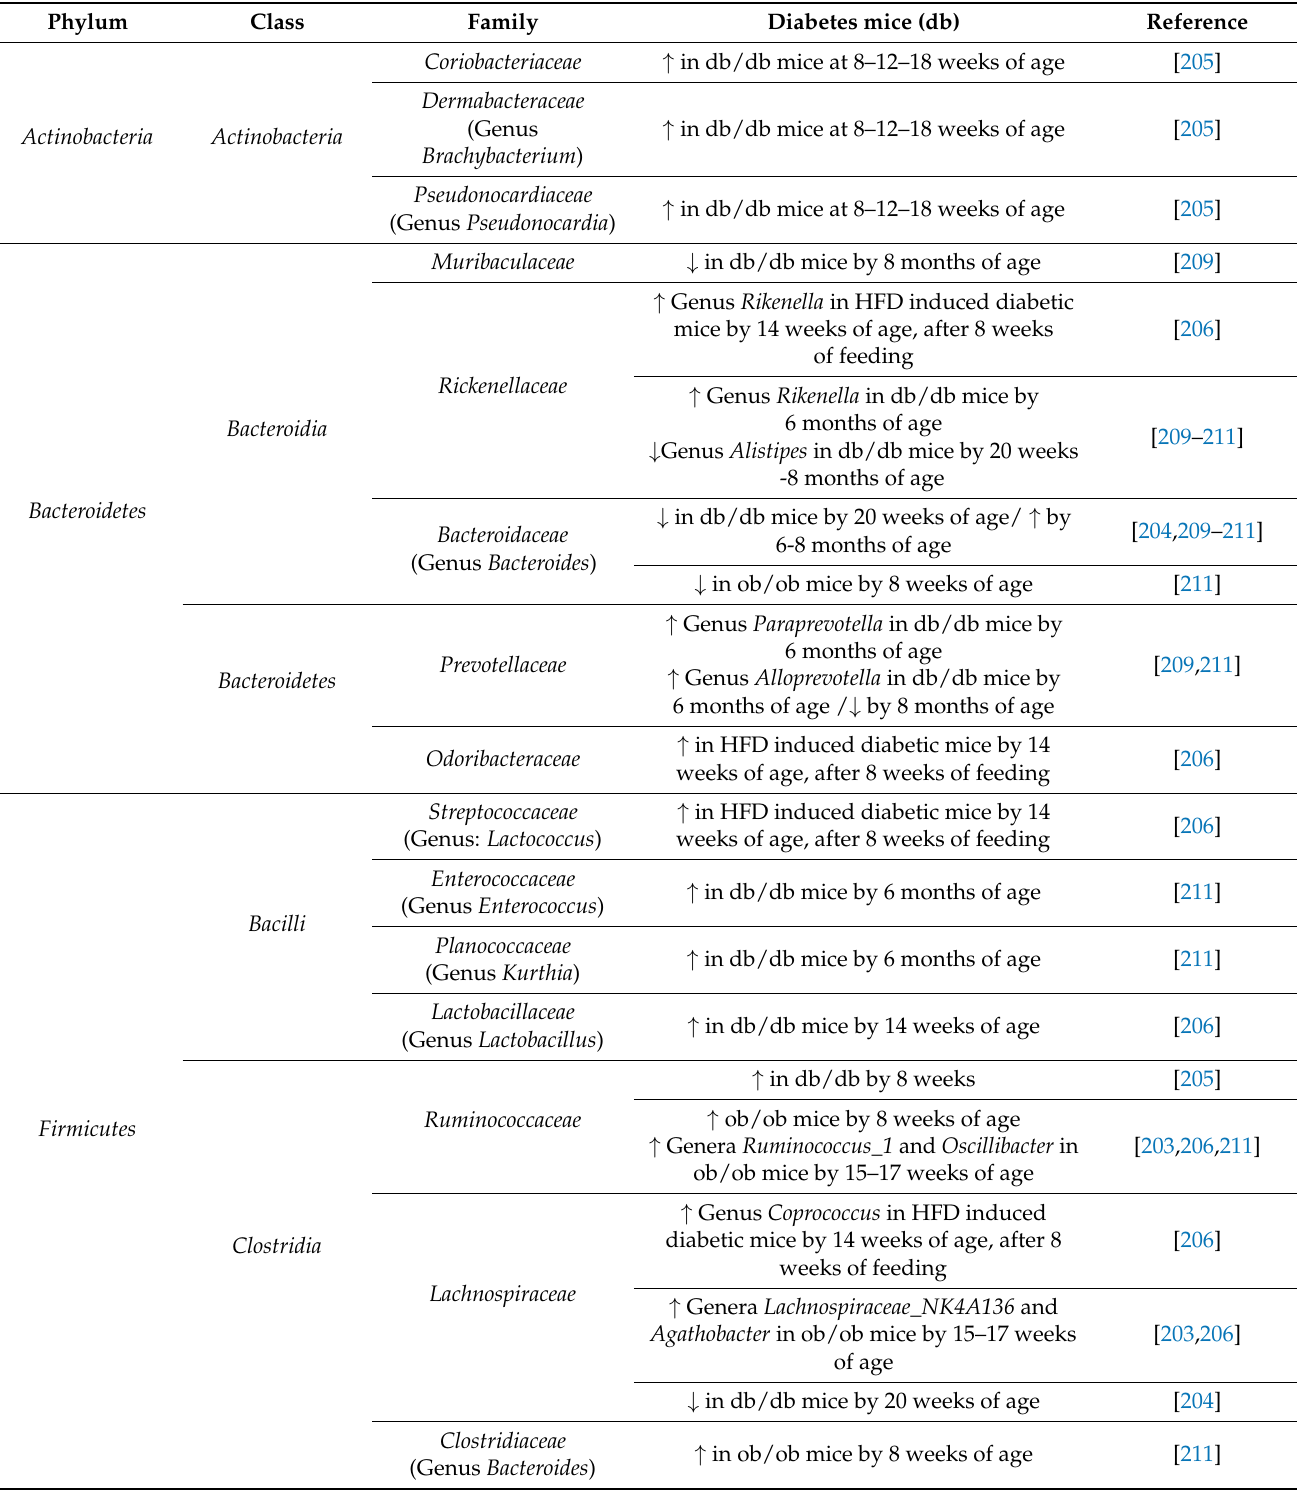
Table 2. Alterations of gut composition in prediabetes and T2DM preclinical